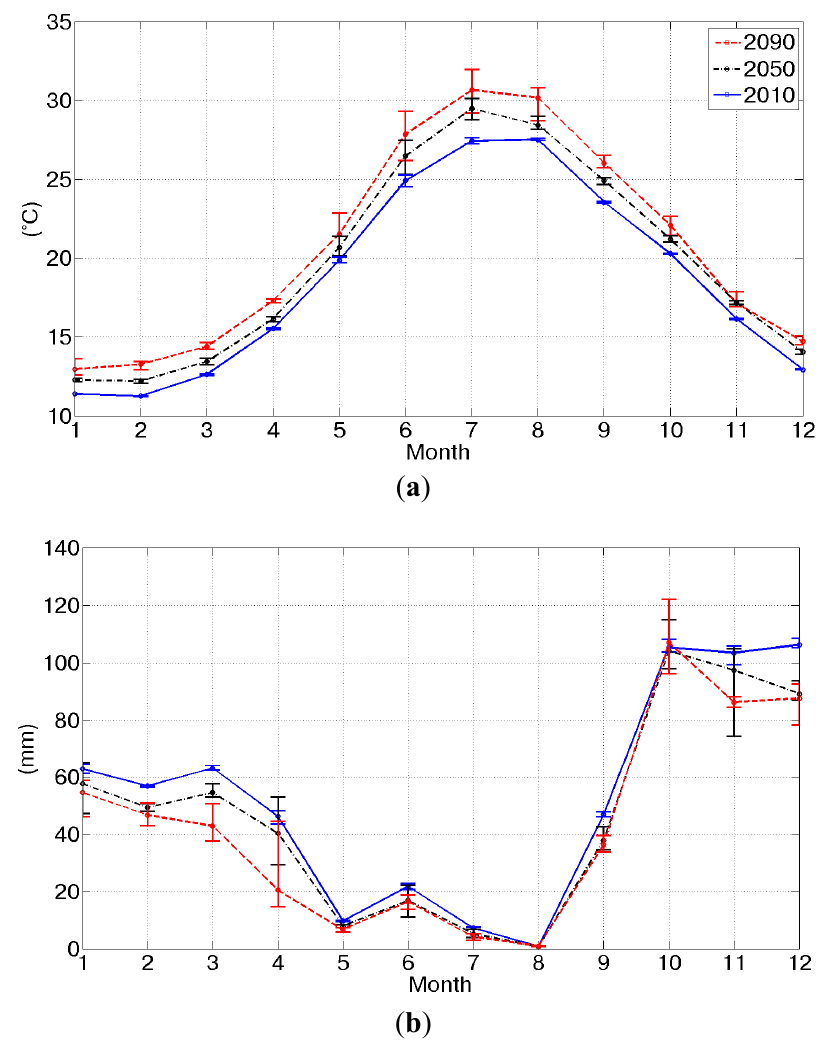
Figure 1. The effect of the factors of change on the annual cycles of monthly temperature and precipitation. The monthly temperature ( a ) and precipitation ( b ) for the scenarios for 2010 (blue line), 2050 (black dashed line) and 2090 (red dashed line) and the 10–90 percentile intervals (vertical